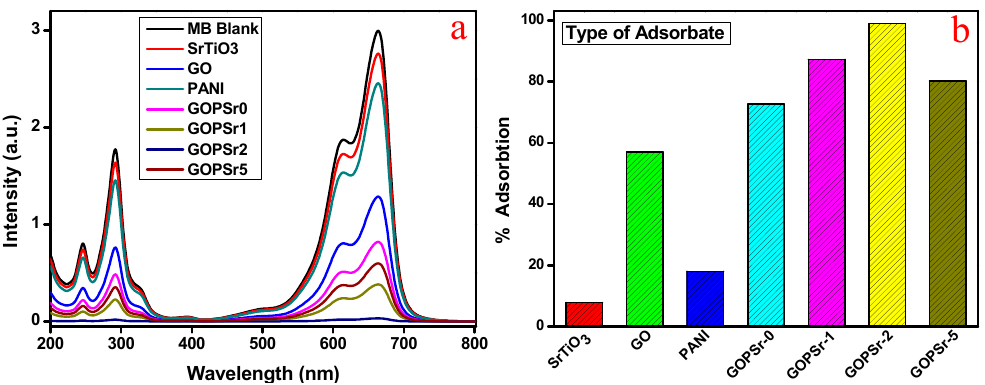
Figure 5. ( a ) UV-vis absorption spectra of MB aqueous in the presence of various adsorbents and ( b ) percentage removal of MB in the presence of various adsorbents (initial MB concentration: 20 mg·L − 1 ; amount of adsorbent: 0.5 mg·mL − 1 ; pH 7; time: 30 min; at room temperature).